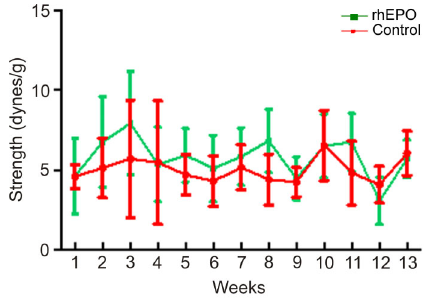
Figure 1. Strength of the entire body of mdx mice treated with recombinant human erythropoietin (rhEPO) or saline (control) for 12 weeks. P . 0.05, GBStat test.